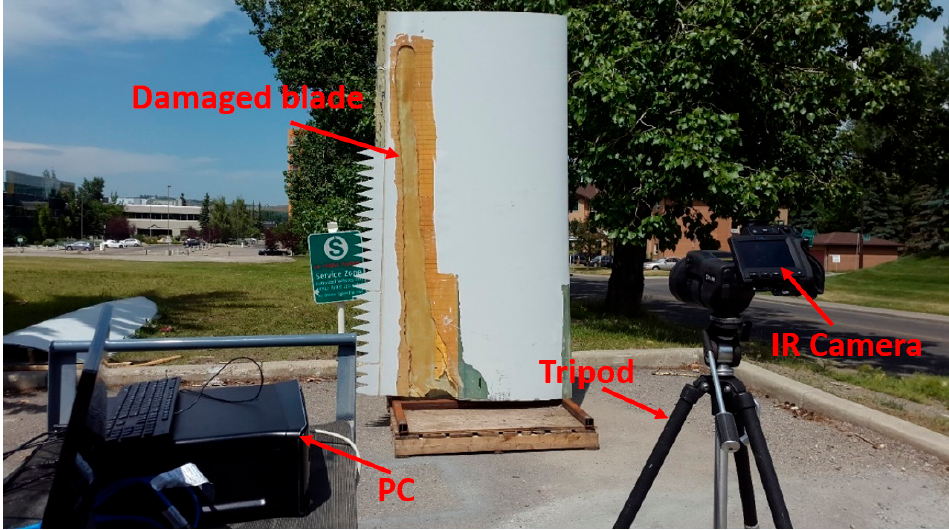
Figure 2. Passive thermography experiment.